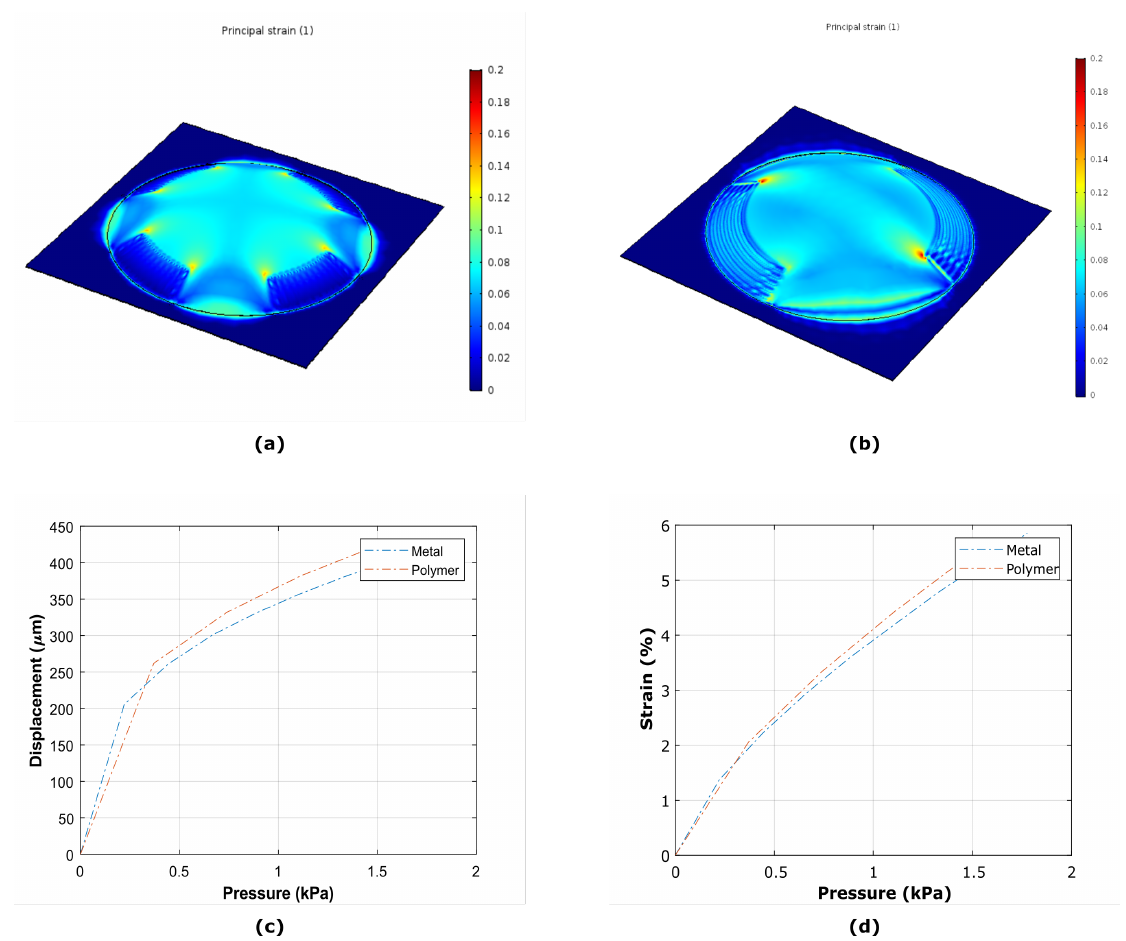
Figure 2. Strain field of the membranes with radial ( a , b ) tangential metal strain gauges for a boundary force corresponding to 2 kPa. ( c ) The curve of the displacement at the center of a membrane with metal (blue line) and polymeric (red line) strain gauges for pressures up to 2 kPa. ( d ) Corresponding average strain of the